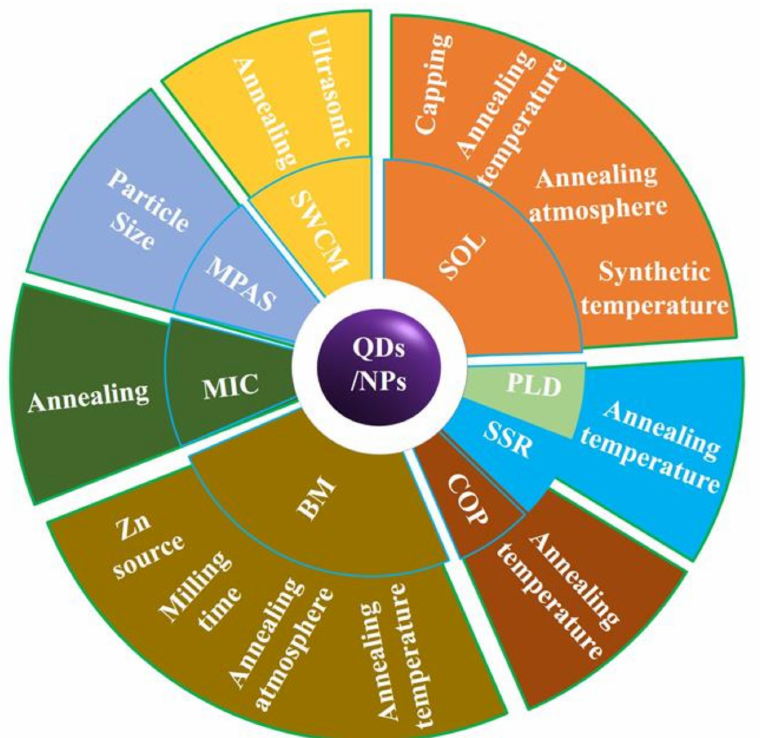
Figure 2. Overview of currently available preparation strategies for fabricating ZnO QDs/NPs with RTFM. Sol-gel (SOL); Pulsed laser deposition (PLD); Solid-state reactions (SSR); Coprecipita- tion (COP); Ball milling (BM); Miceller method (MIC); Microwave plasma assisted spray (MPAS); Surfactant-free wet chemical method (SWCM).